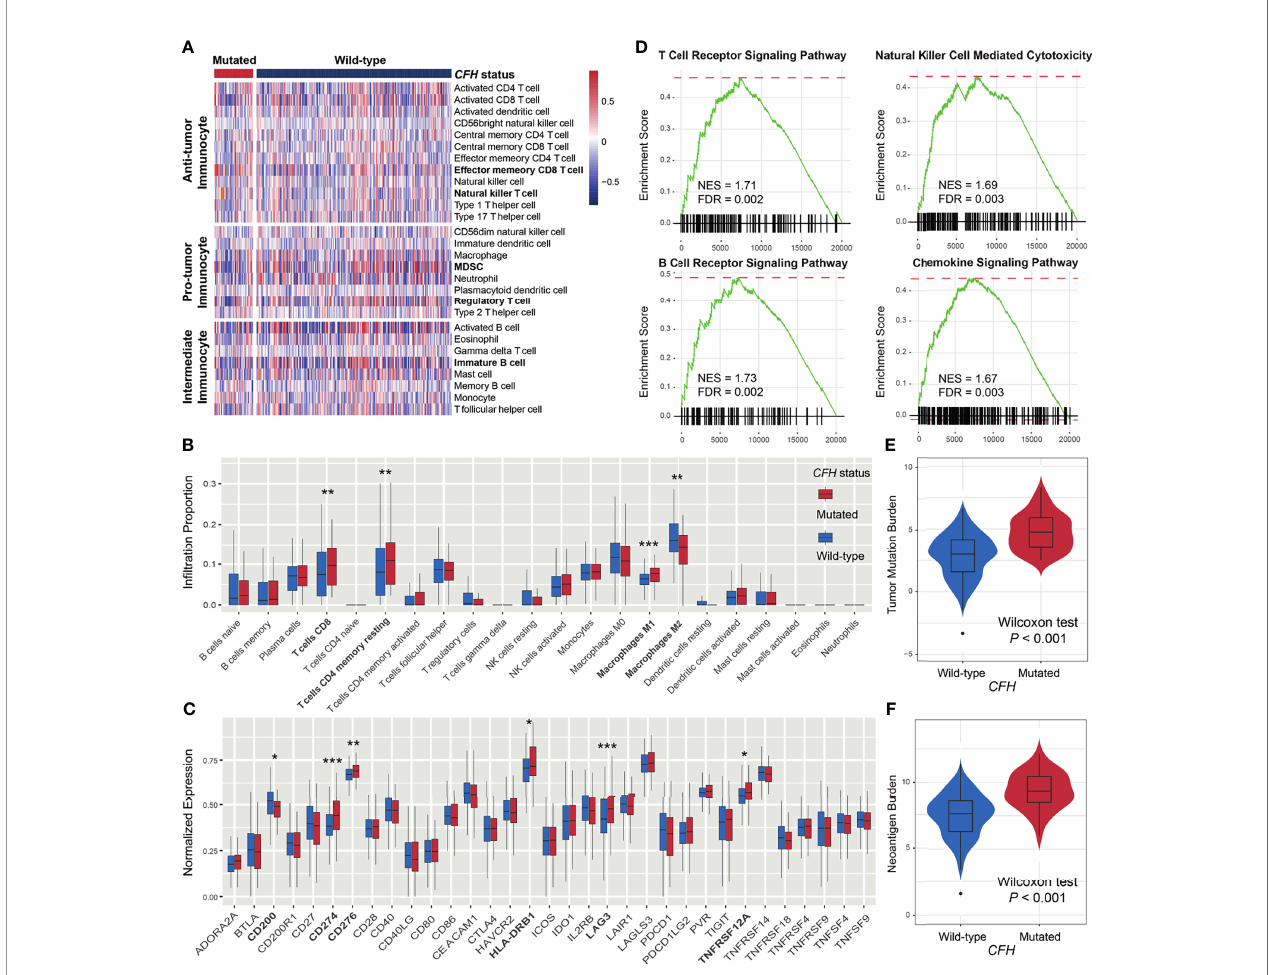
FIGURE 3 | Lymphocyte in fi ltration, immune response pathways, and genomic features associated with CFH mutations in male patients. (A) Distinct immune cell subsets and (B) lymphocyte in fi ltration evaluation based on CFH mutational status achieved by the ssGSEA and CIBERSORT algorithm, respectively. (C) Boxplot representation of the expression of 33 immune checkpoint genes strati fi ed by CFH status. (D) The immune response-related pathways of CFH -mutated patients obtained from the GSEA method. The varied distributions of (E) TMB and (F) NB in CFH mutated versus wild-type subgroups. Factors highlighted in bold were identi fi ed to be statistically different in distinct sex groups. * P < 0.05; ** P < 0.01; *** P <